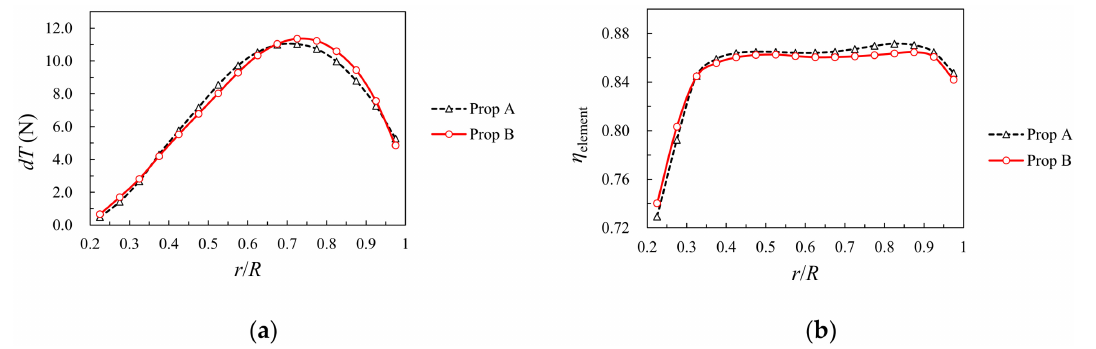
Figure 34. Aerodynamic characteristics along the blade of two propellers at State 1: ( a ) Distributions of blade element thrust; ( b ) Distributions of blade element efficiency.